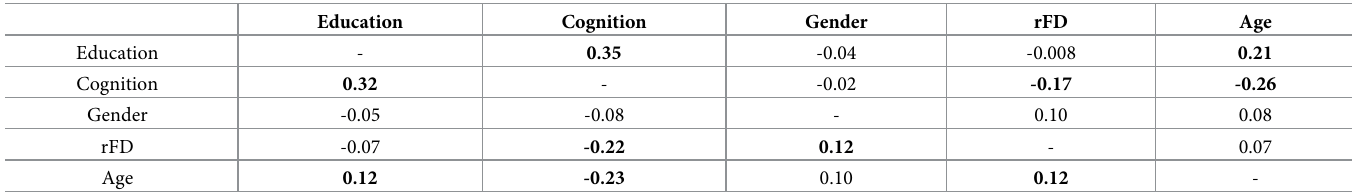
Table 5. Relationships between all subject non-brain variables (= Pearson R). Bolded values denote statistical significance at p < 0.05. The upper triangle lists partial cor- relations, the lower triangle unadjusted bivariate correlations. (rFD = Relative frame-wise displacement. Gender is coded as 1 = men, 2 =